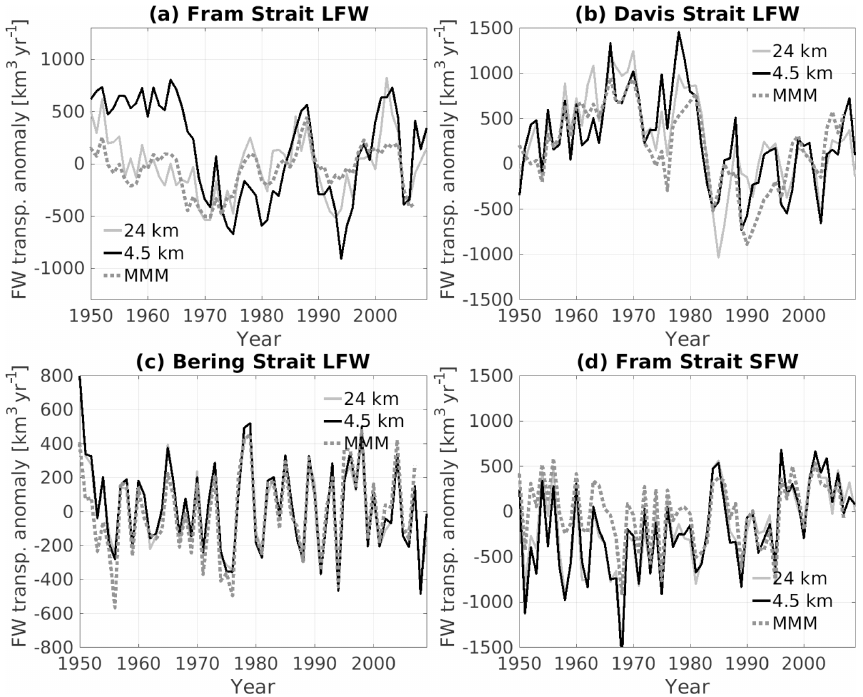
Figure 13. Anomalies of annual mean FW transport through main Arctic gateways. Liquid FW transport through the (a) Fram Strait, (b) Davis Strait, and (c) Bering Strait, and solid FW transport through the (d) Fram Strait. The dotted lines show the multi-model means (MMMs) obtained from 13 CORE-II models (Wang et al., 2016a, b). The whole integration period of 1950–2009 is